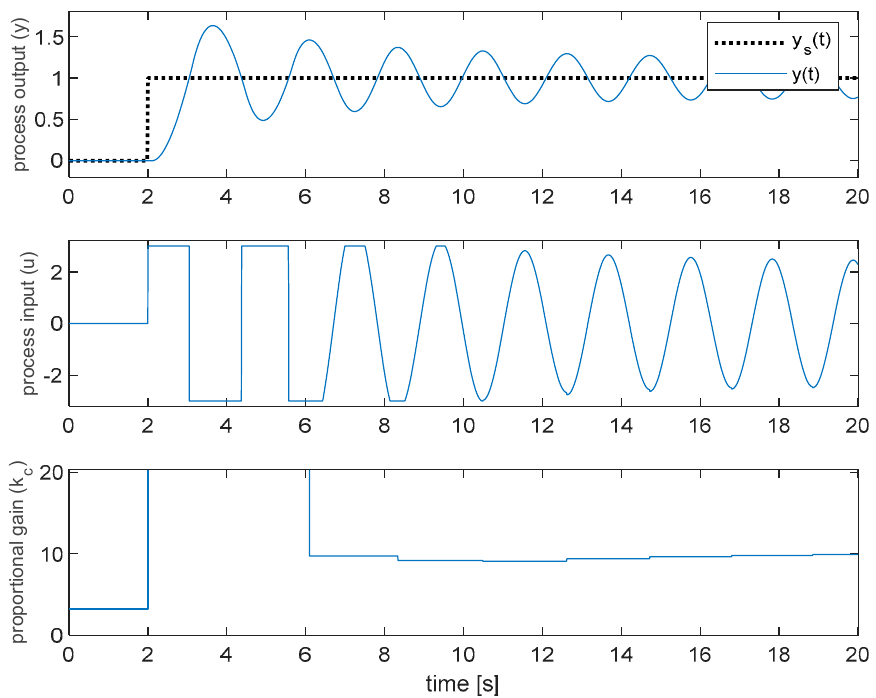
Figure 17. Response of the proposed method for the integrating process and PA set = − π .